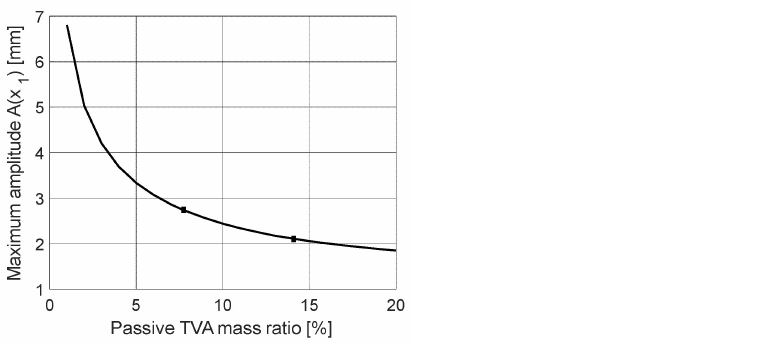
Figure 2. Maximum nacelle horizontal displacement amplitude A ( x 1 ) vs. passive TVA mass ratio (tuned according to